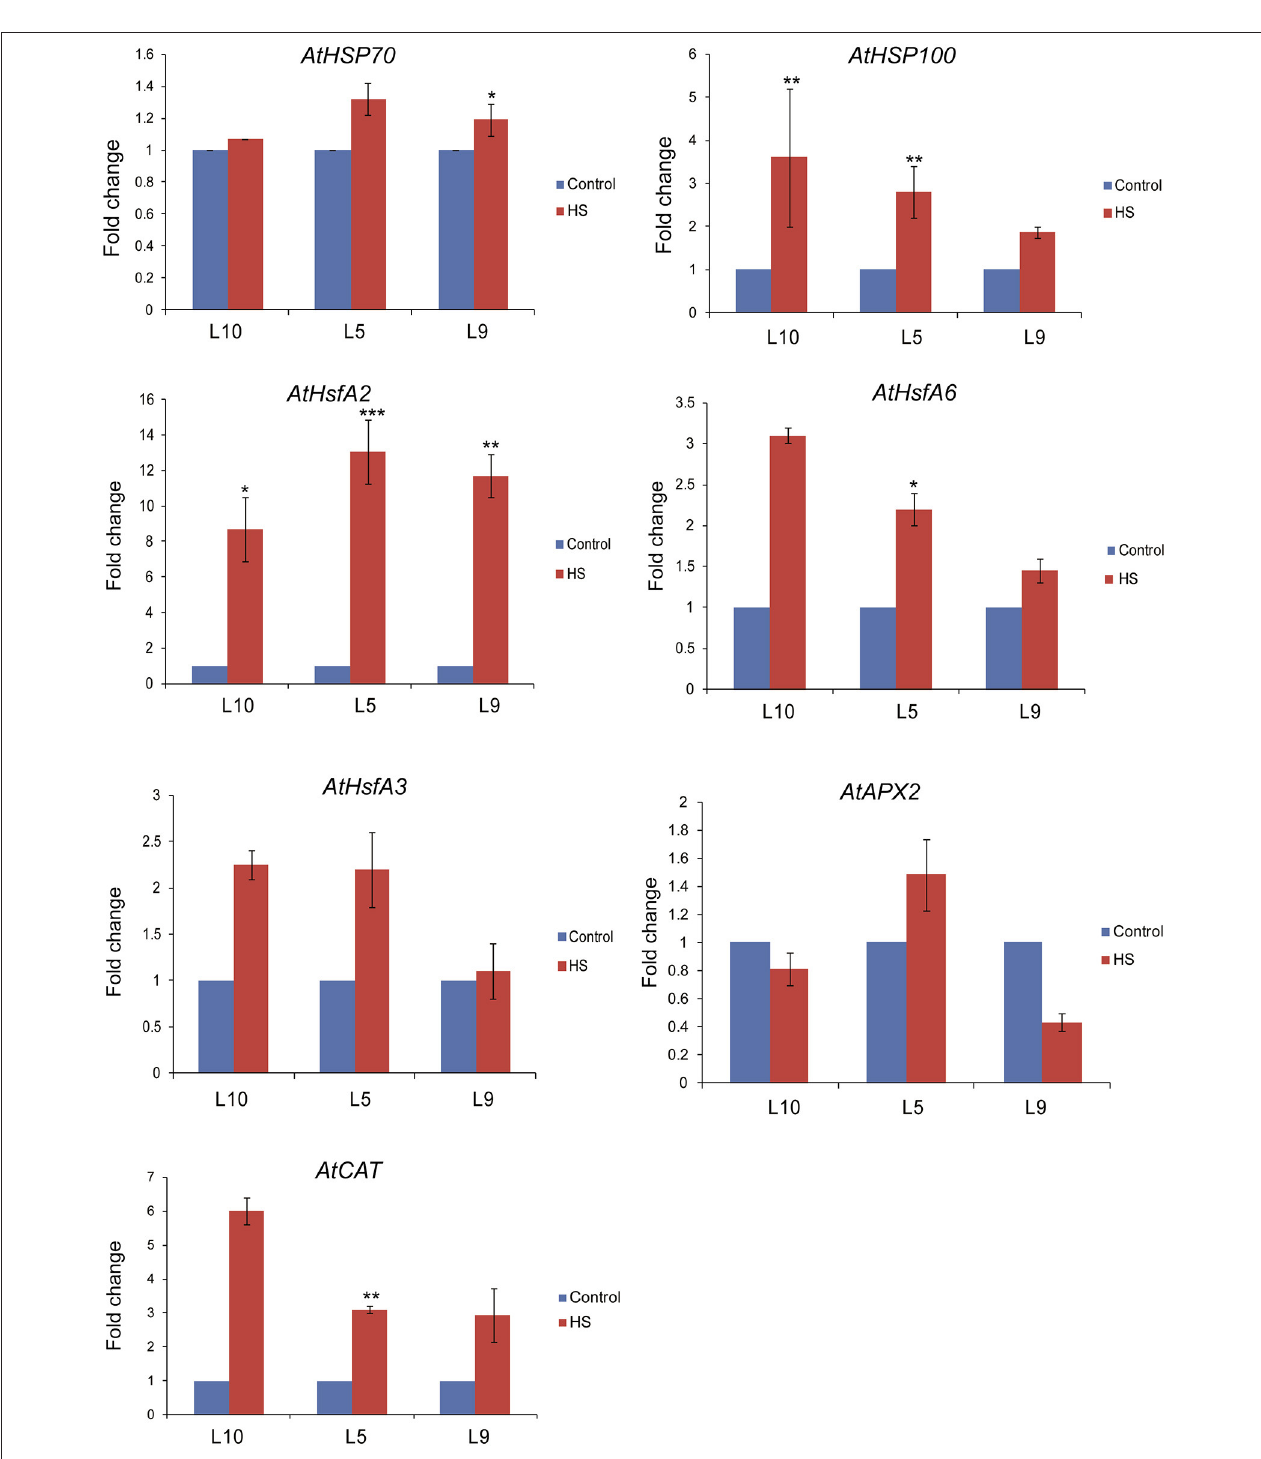
FIGURE 8 | Expression analysis of heat stress marker genes by qRT-PCR of WT and Arabidopsis transgenics under control and heat stress. Transcript levels were normalized to WT and AtActin was used as an internal control. Error bars indicate values ± SD. Asterisks on top of the error bars represent the significance levels (Students t -test; p ≤